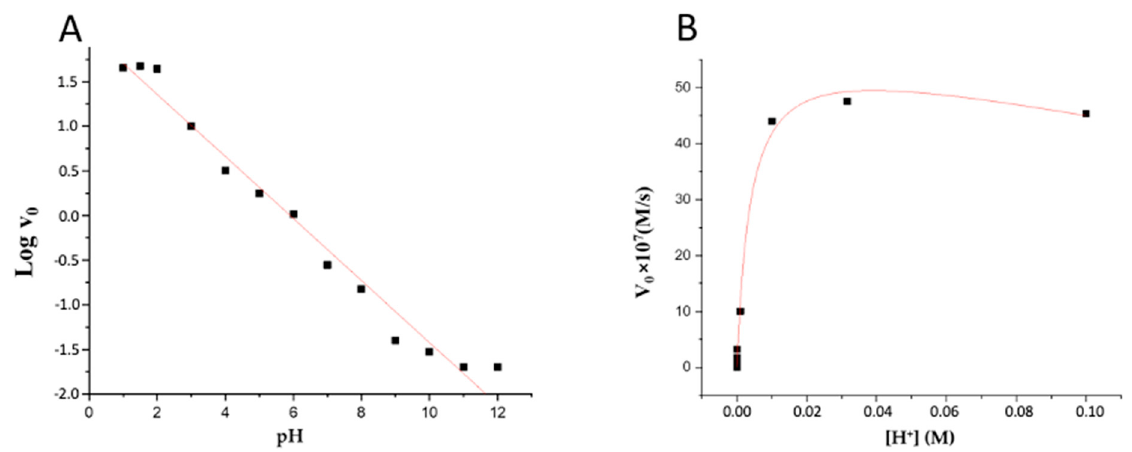
Figure 4. Influence of pH on the initial reaction rate. [HOONO]= 8.00 × 10 − 5 M, [BZH]= 4.00 × 10 − 5 M, I = 0.1M, T = 25 °C. ( A ) Specific acid catalysis. ( B ) initial rate versus [H + ].